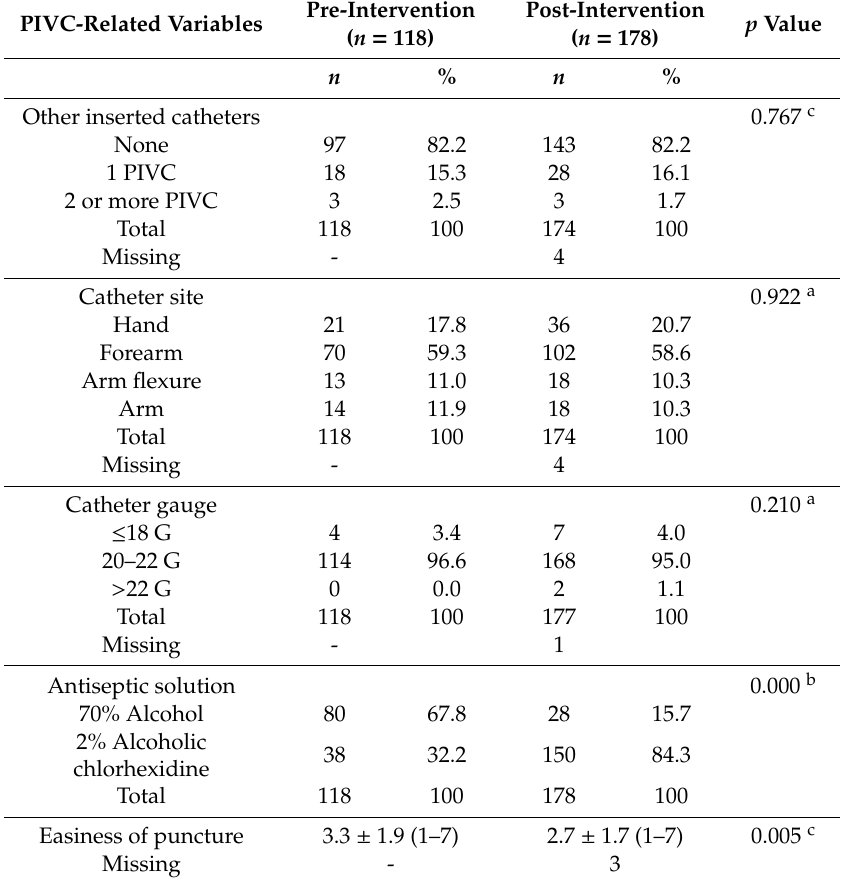
Table 2. Characterization of PIVC insertion and catheter dwell time in each phase and the statistical significance between pre- and post-intervention phases ( n =